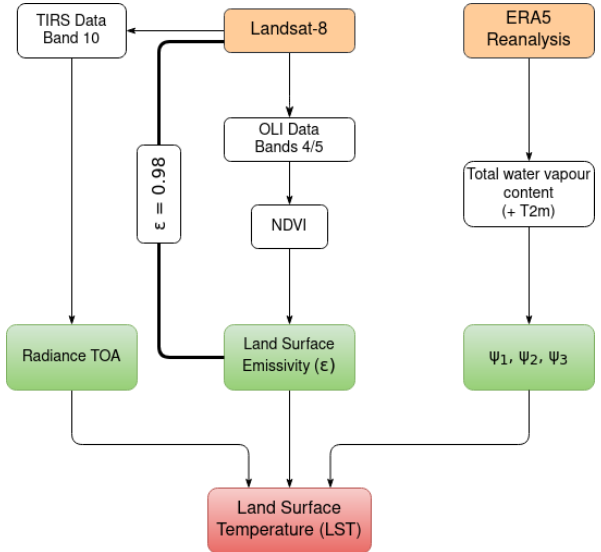
Figure 4. Workflow to retrieve land surface temperature from Land- sat 8 thermal observations with a single-channel